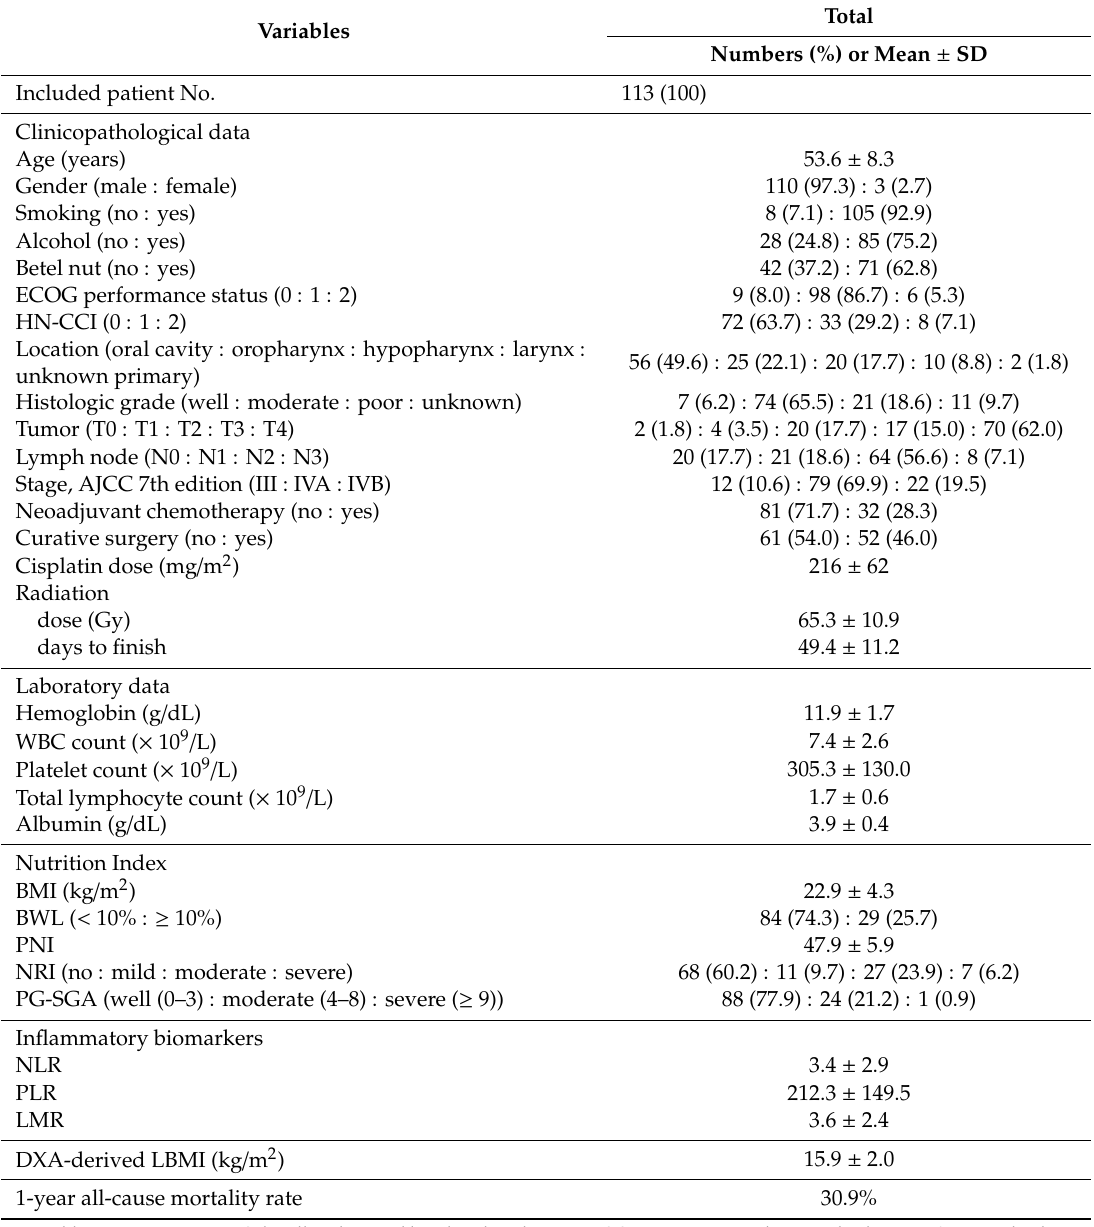
Table 1. Pretreatment baseline characteristics of LAHNC patients undergoing